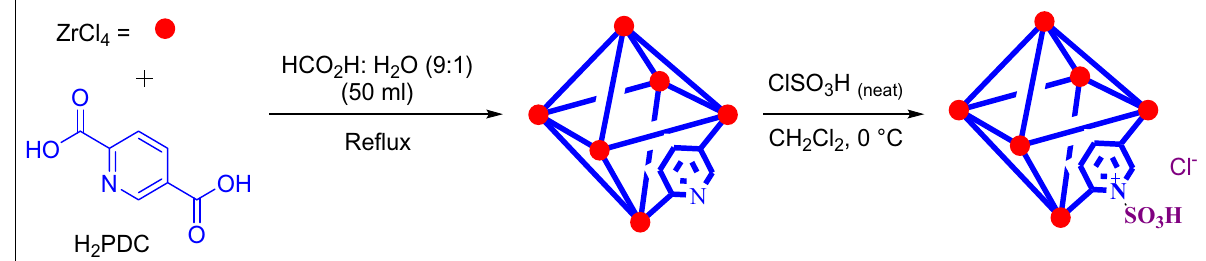
Figure 12. Chemical synthesis of [Zr-UiO-66-PDC-SO 3 H]Cl as a functionalized MOF